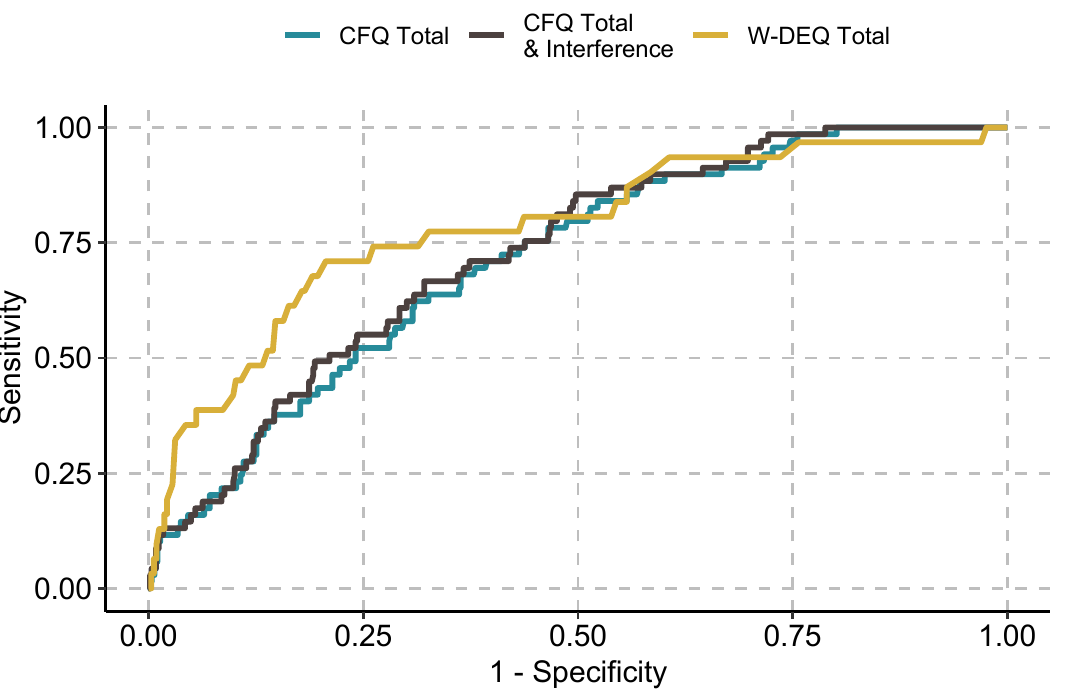
Figure 1. Receiver operating characteristic (ROC) curves for the Childbirth Fear Questionnaire (CFQ) and the Wijma Delivery Expectations Questionnaire (W-DEQ) for the full sample (full diagnostic criteria ONLY).